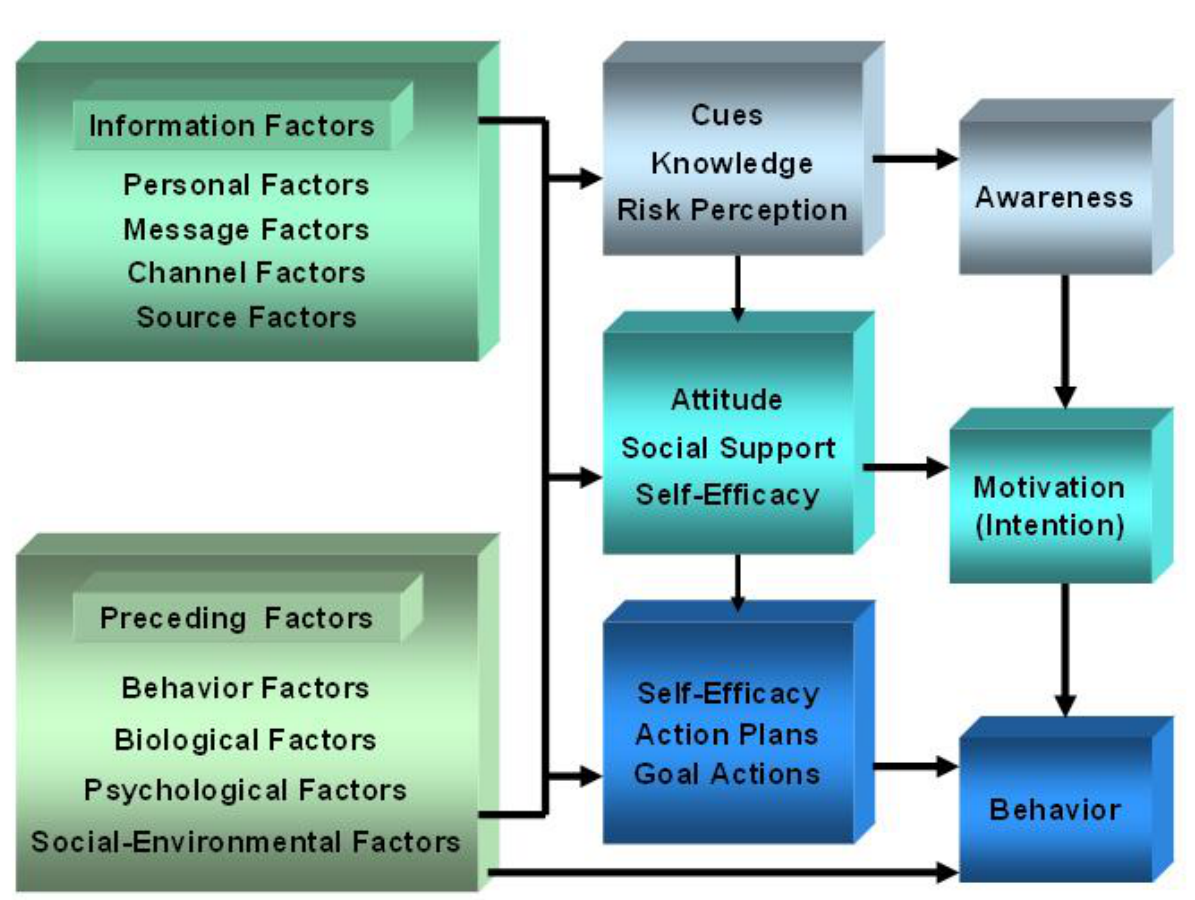
Figure 1. The I-Change Model